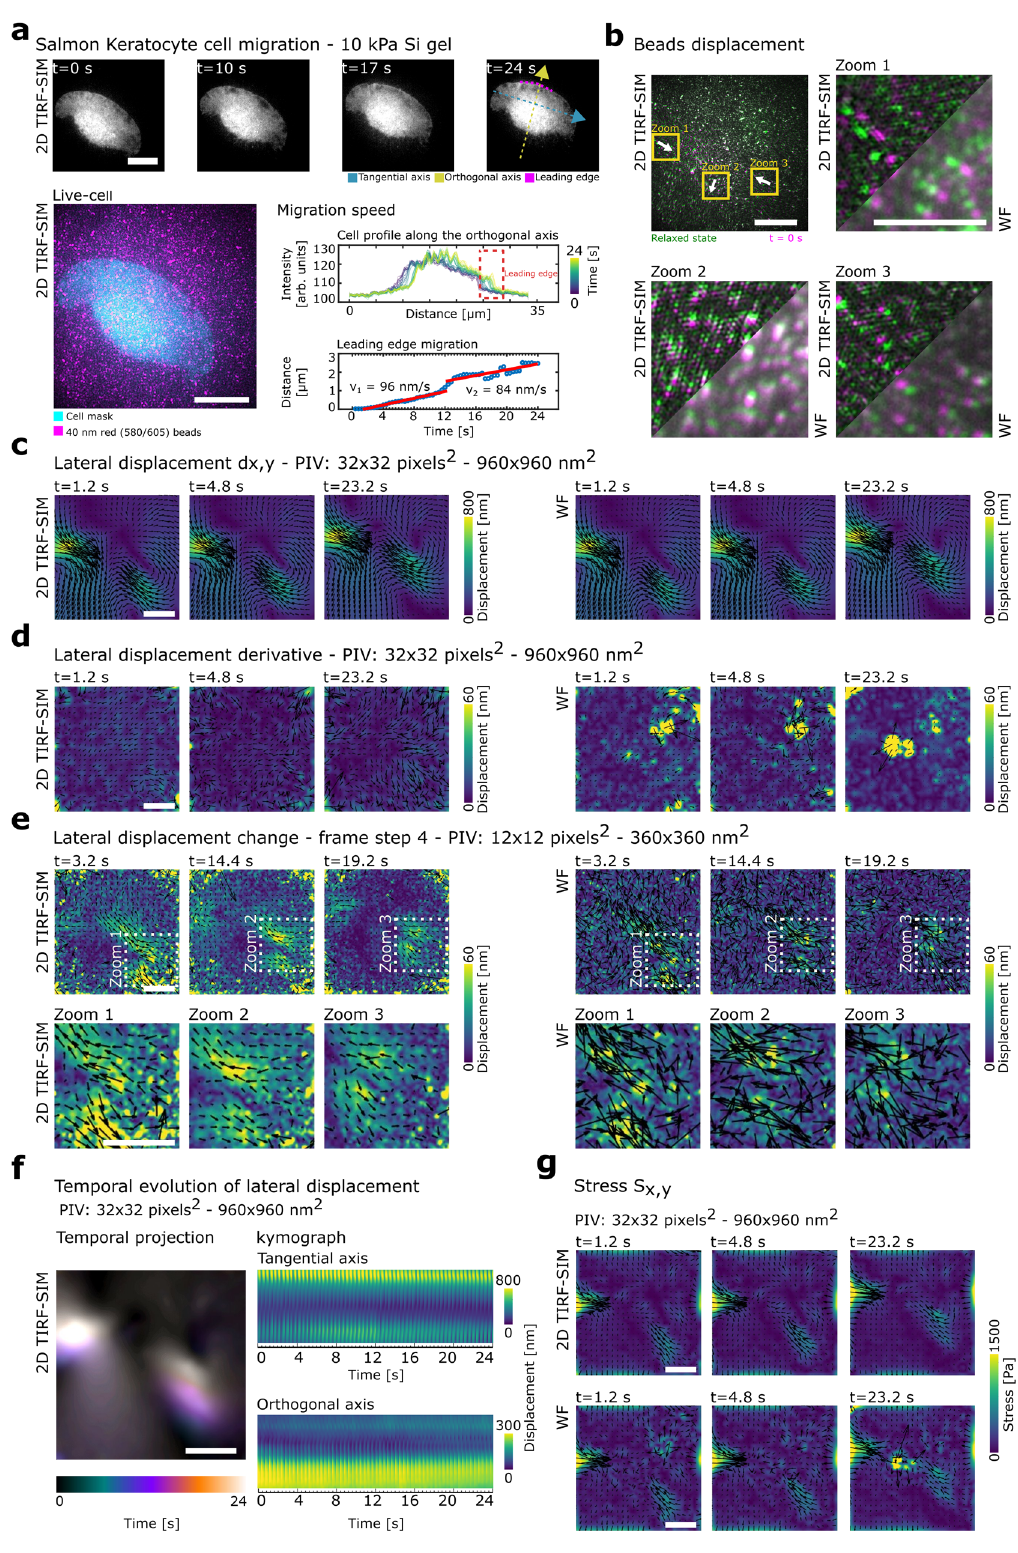
fail in estimating large displacement values (Supplementary Fig. 3). To capture large displacements, a PIV window size of 32 px was selected to recover the overall displacement compared to the relaxed gel state (Fig. 3c and Supplementary Movie 8). To assess the temporal evolution of fl uctuations that may exist in the force generation over time, we analysed the derivative of the